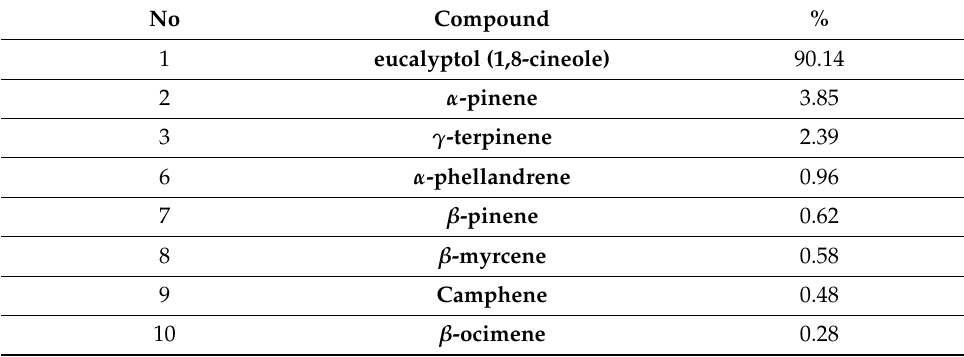
Table 2. Chemical composition of